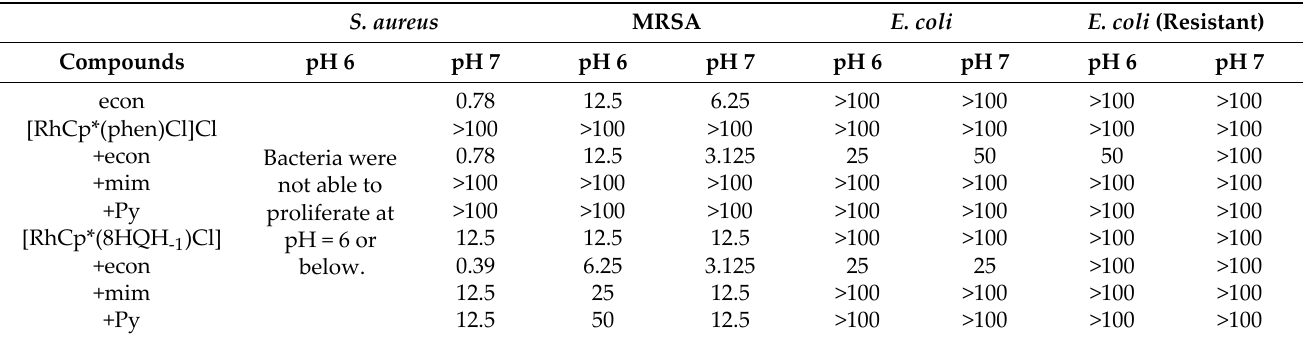
Table 4. Minimal inhibition concentration (MIC) values ( µ M) of monodentate